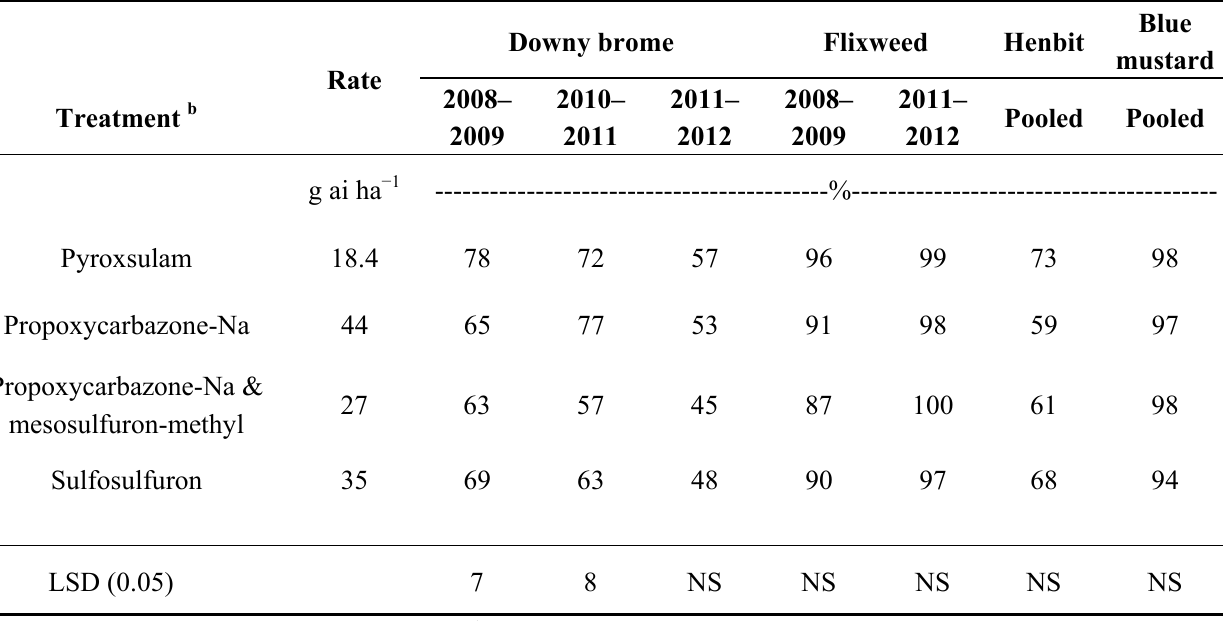
Table 3. Efficacy of acetolactate synthase (ALS)-inhibiting herbicides on downy brome and broadleaf weed control in winter wheat averaged across time of application, Hays, KS, USA, 2008–2012 a